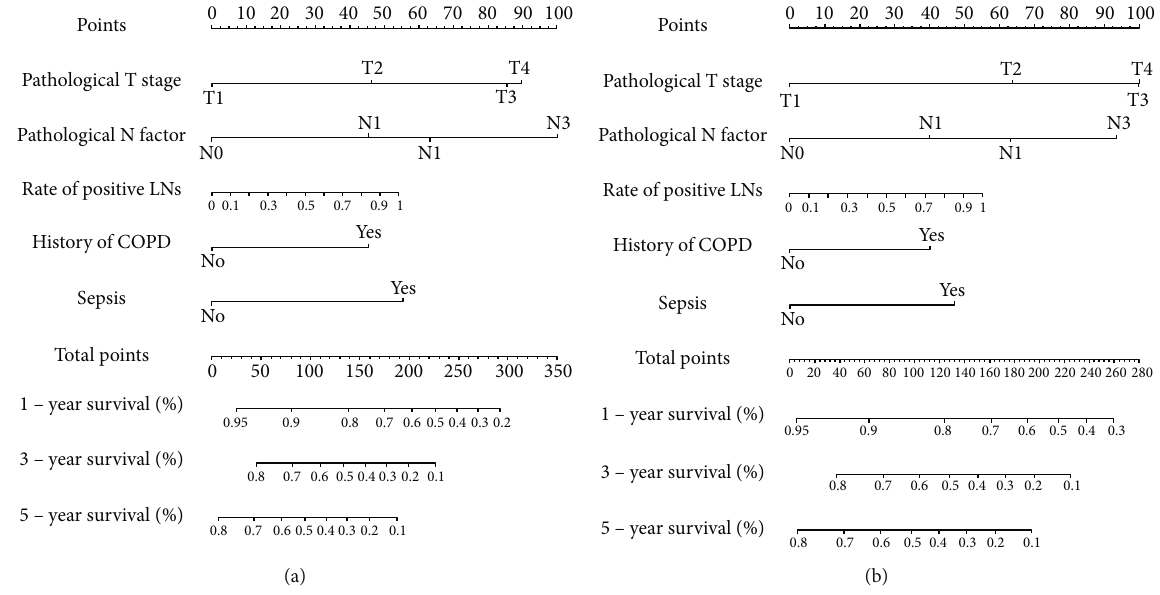
Figure 1: Survival nomogram for patients with resected esophageal squamous cell carcinoma (to use the nomogram, an individual patient ’ s value is located on each variable axis, and a line is drawn upward to determine the number of points received for each variable value. The sum of these number is located on total point axis, and a line is drawn downward to the survival axes to determine the likelihood of 1-, 3- or 5-year survival. (a) is for overall survival; (b) is for disease free